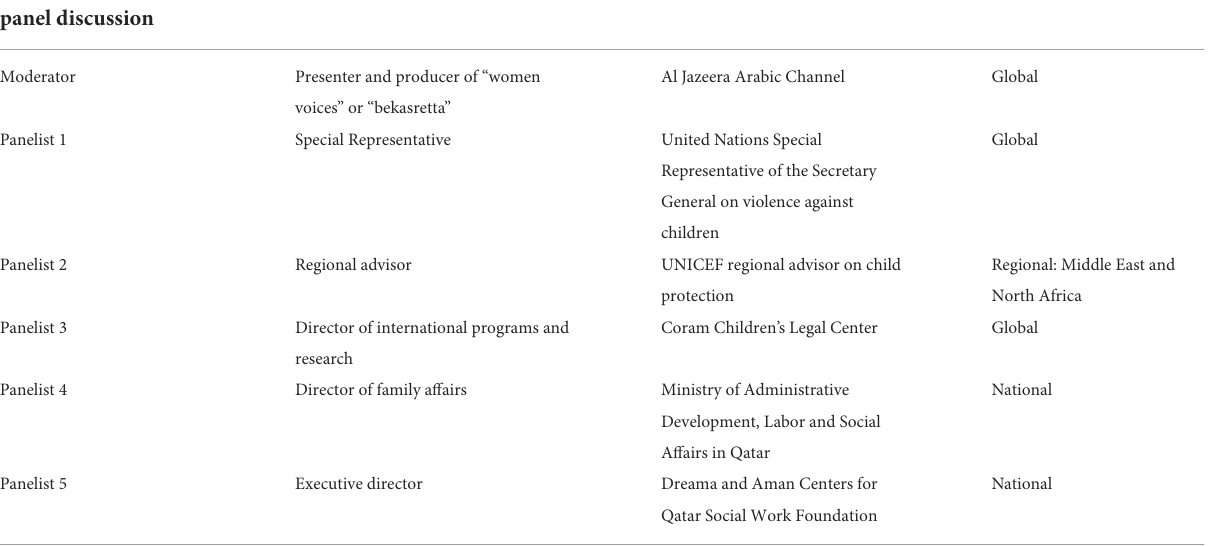
TABLE 1 Characteristics of